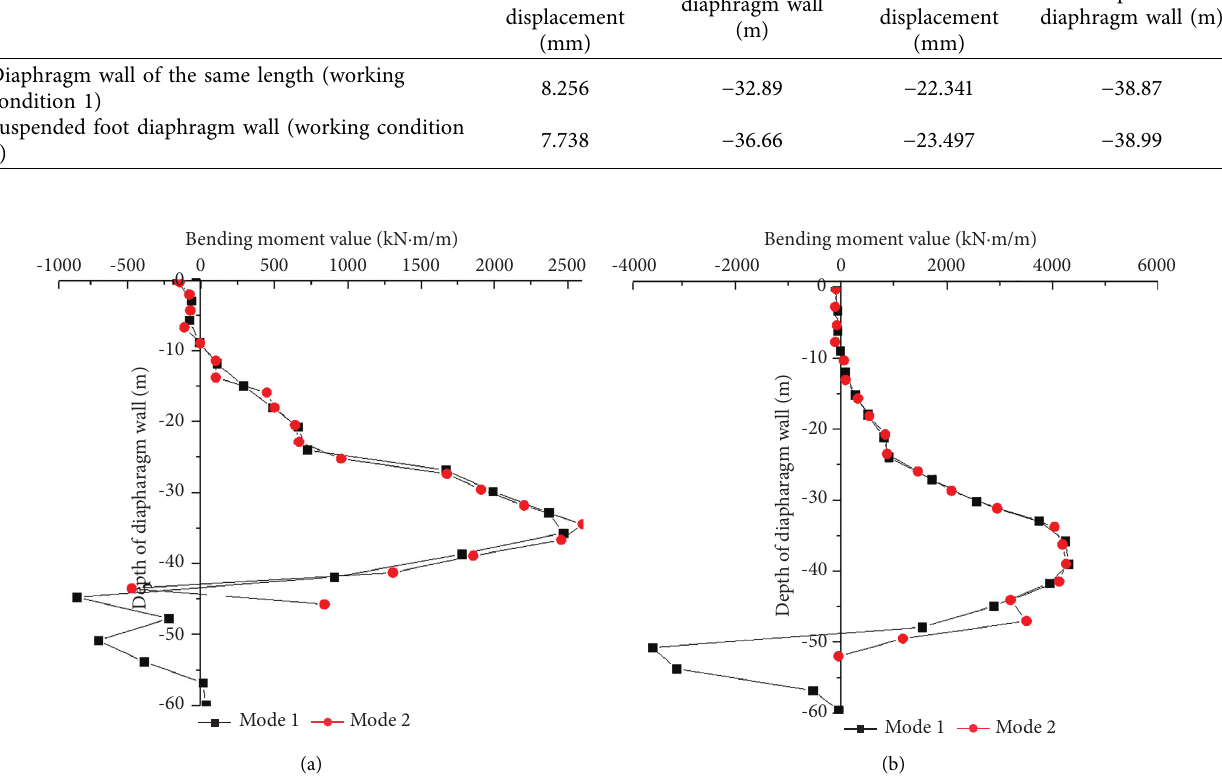
Figure 19: Bending moment diagram of the diaphragm wall. (a) West wall. (b) East